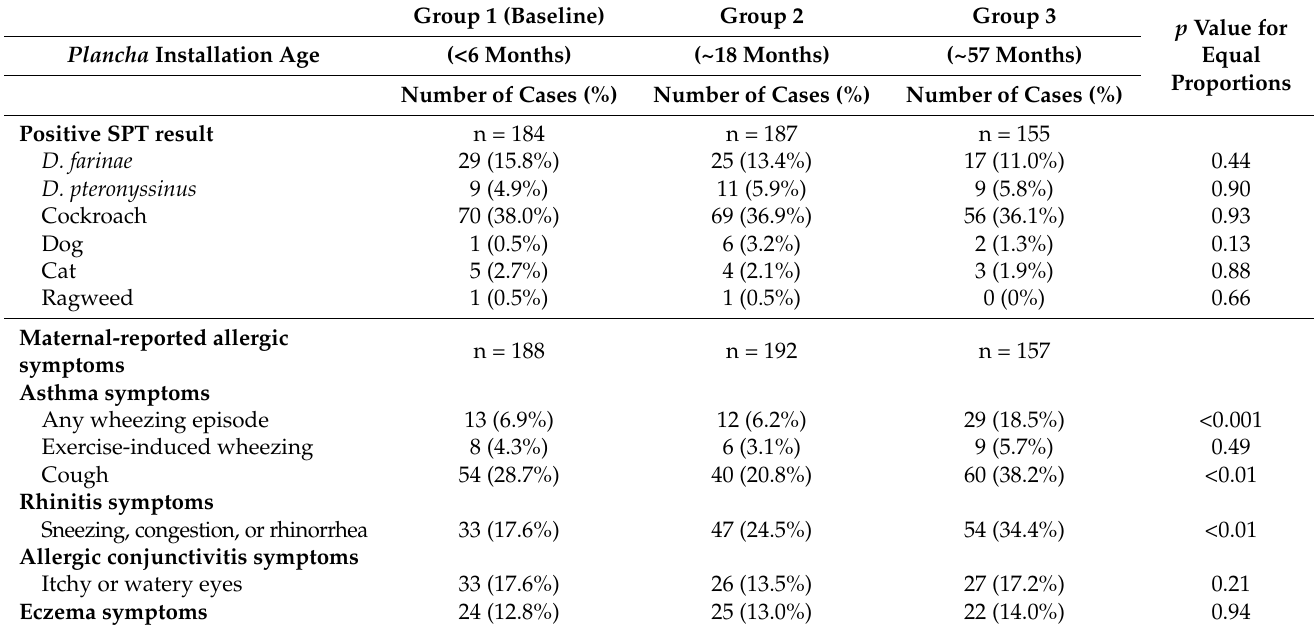
Table 3. Skin Prick Test (SPT) results and self-reported allergic symptoms by study group.